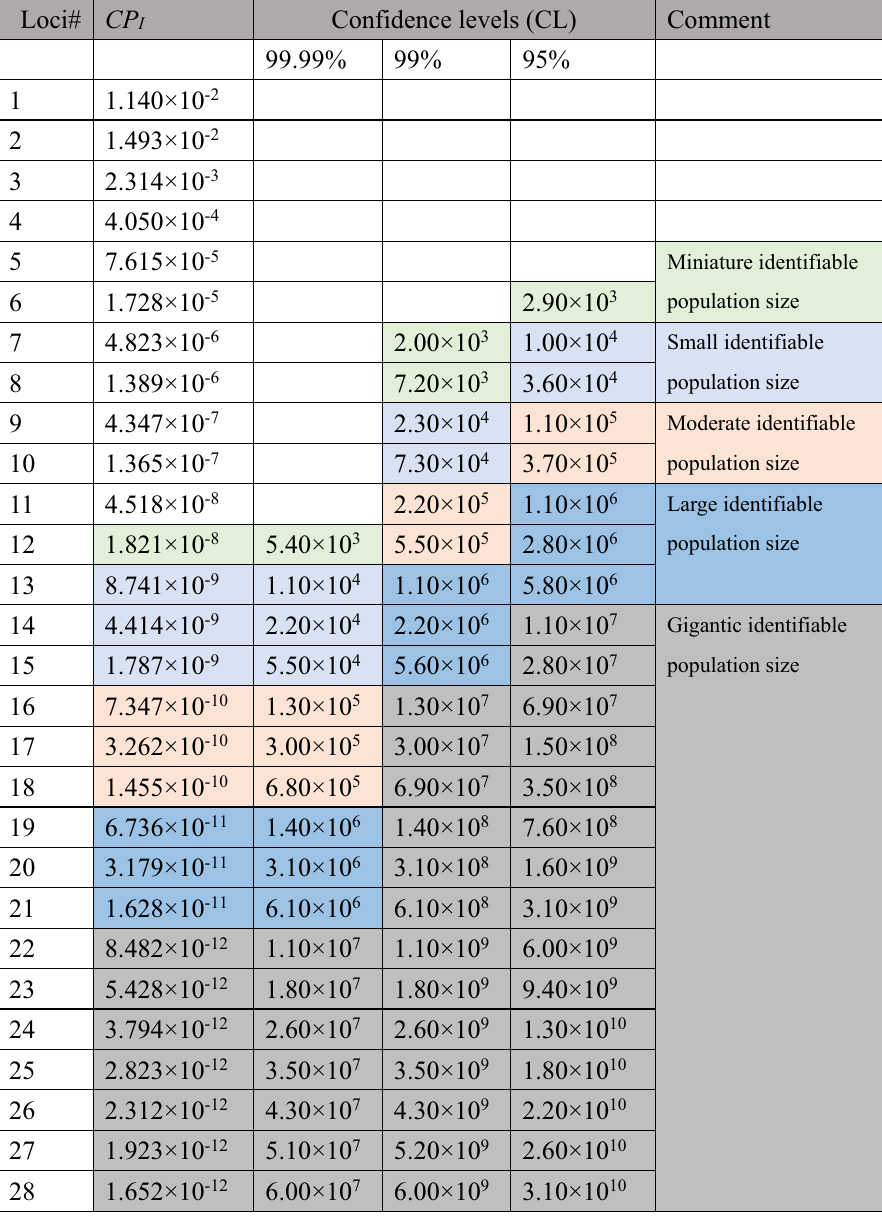
Table 3. The discrimination power in SSR marker combination. CP I cumulative random probability of identity, CL = (1- CP I ) N , N number of